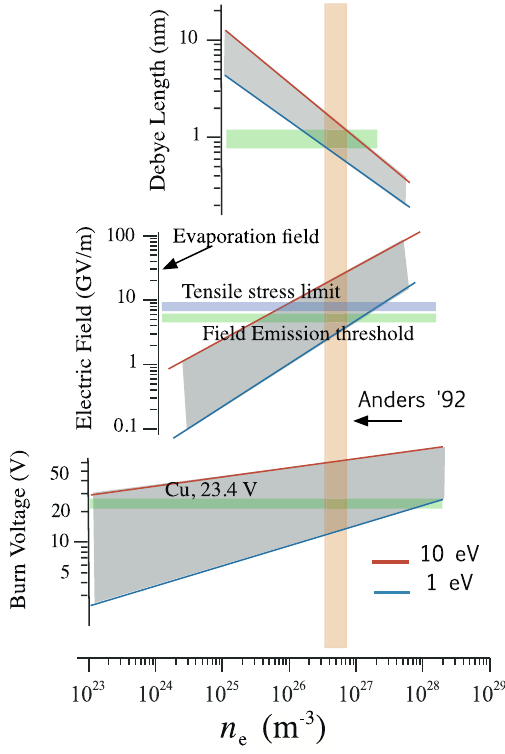
Figure 5. The interaction between measured properties, (surface field and burn voltage) and electron temperature T e and density, n e from sheath calculations, with density measurement by Anders et al. 35,36